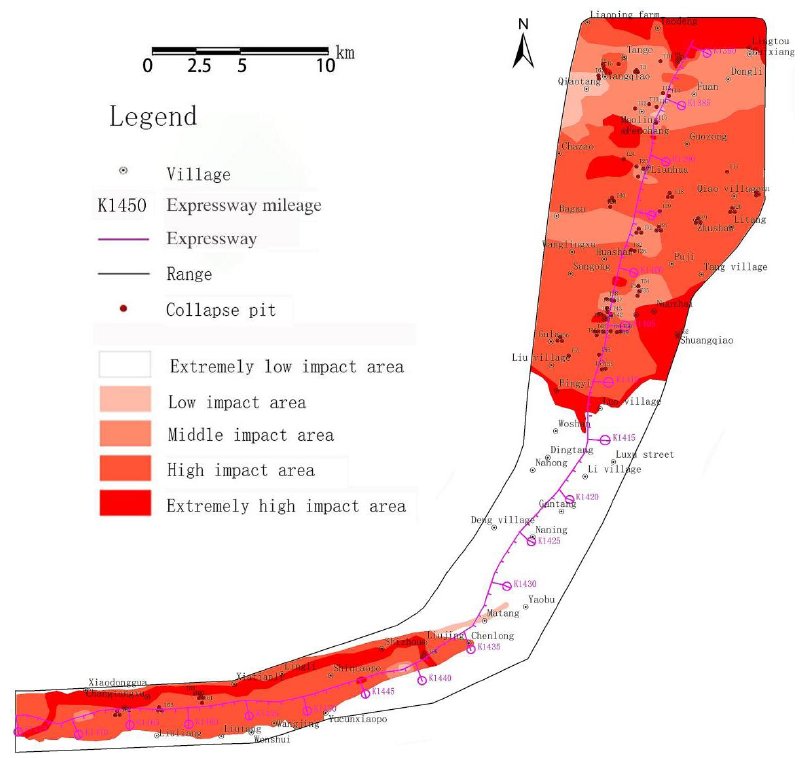
Figure 11. Zoning map of influence degree of soil thickness on karst collapse.